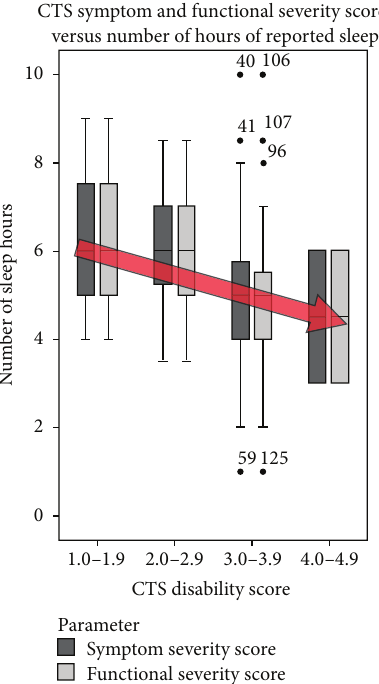
Figure 4: CTS disability score (SSS and FSS) versus total number of hours asleep. A significant negative correlation was demonstrated between increasing CTS and total sleep hours ( 𝑟 = −0.288 , 𝑃 < 0.023 ). Bars indicate 95% min and max values.